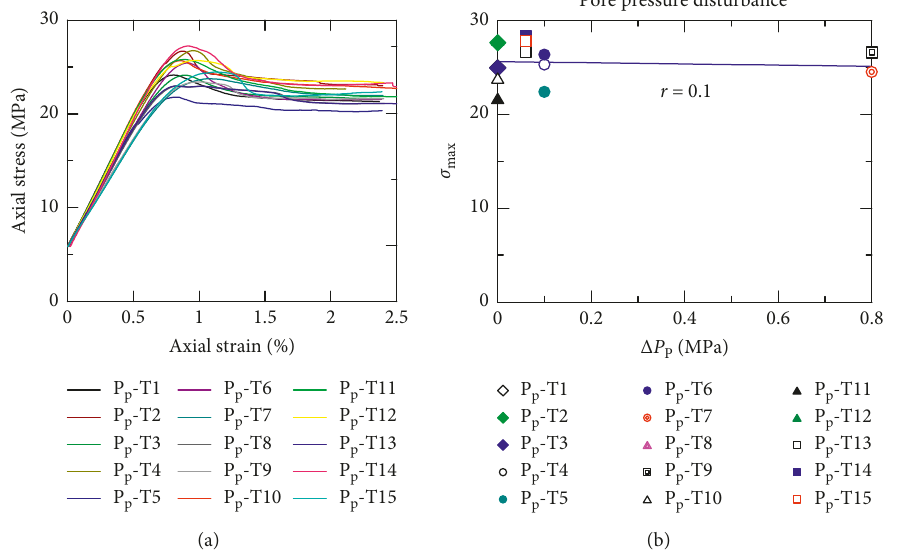
Figure 16: (a) Stress-strain curves and (b) maximum stress ( σ welded tuff.